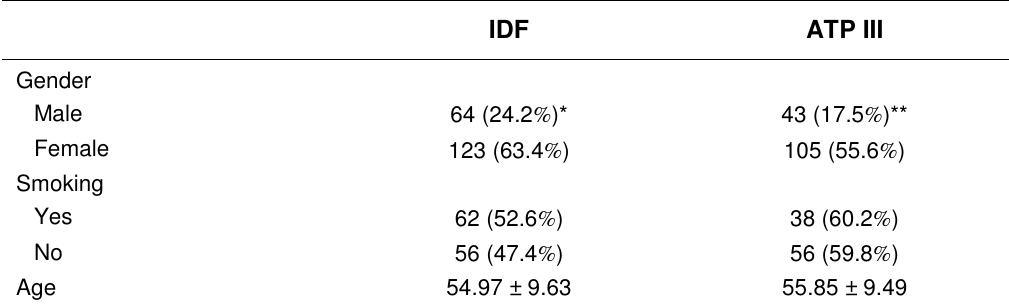
Values expressed as mean ± SD ; IDF, MS based on International Diabetic Federation definition ; ATP III, MS based on Adult Treatment Panel III definition ; between groups comparisons were assessed by chi-square or t-test ; * p < 0.001, ** p <